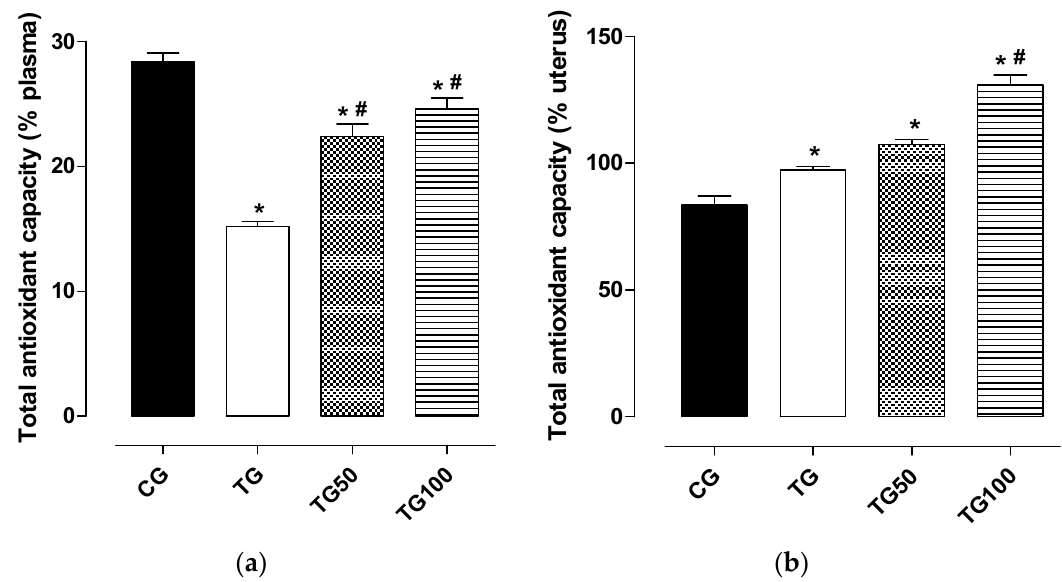
Figure 4. Effect of strength training and/or food supplementation with S. platensis on the percentage of antioxidant capacity in plasma ( a ) and in uterus ( b ) in rats, in CG, TG, TG50 and TG100.The symbols and vertical bars represent the mean and the e.p.m., respectively ( n = 5). ANOVA one-way followed by Tukey’s post-test, * p < 0.05 (TG, TG50 and TG100 vs. CG); # p < 0.05 (TG50 and TG100 vs. TG). CG = control group; TG = trained group; TG50 = group trained and supplemented with S. platensis at a dose of 50 mg/kg; TG100 = group trained and supplemented with S. platensis at a dose of 100 mg/kg.